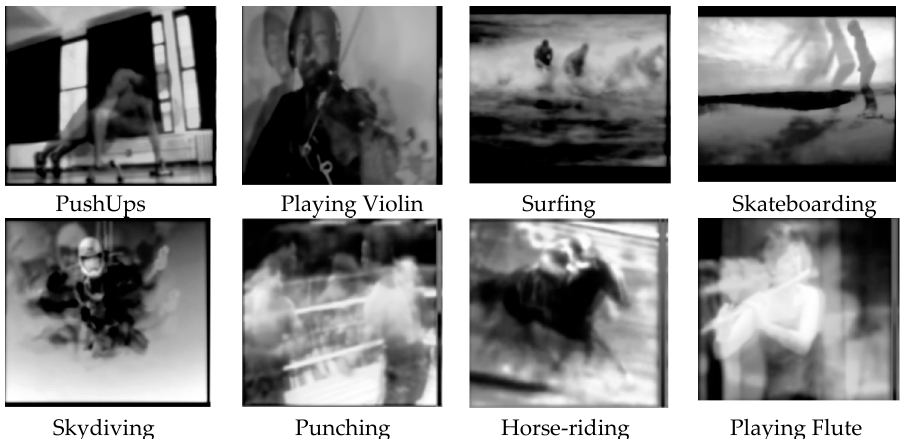
Figure 2. Output Motion map generated by our network, illustrating the discriminative information integrated into a single motion map to classify the video category.